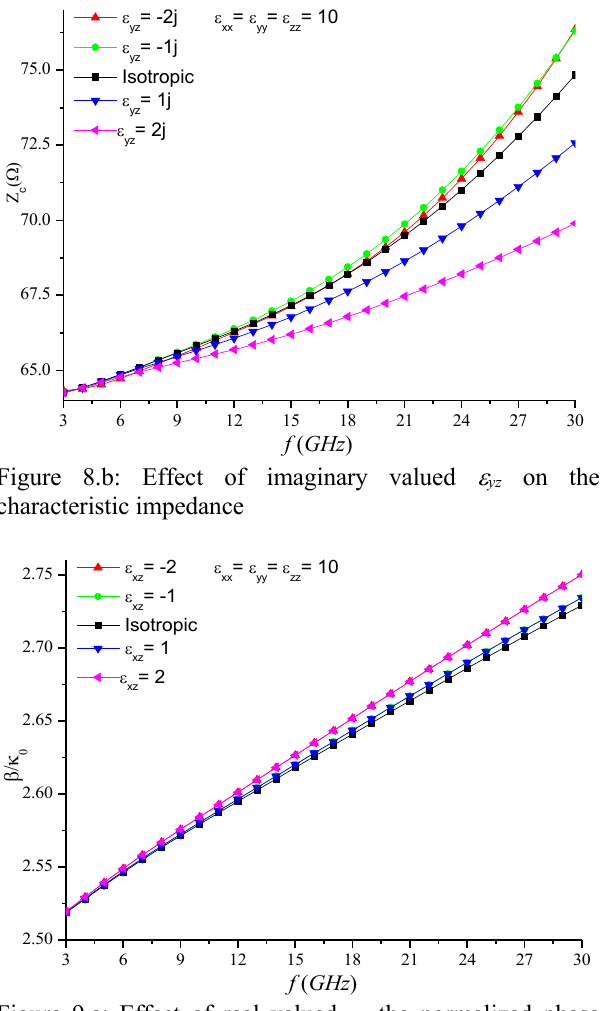
Figure 9.a: Effect of real valued e constant